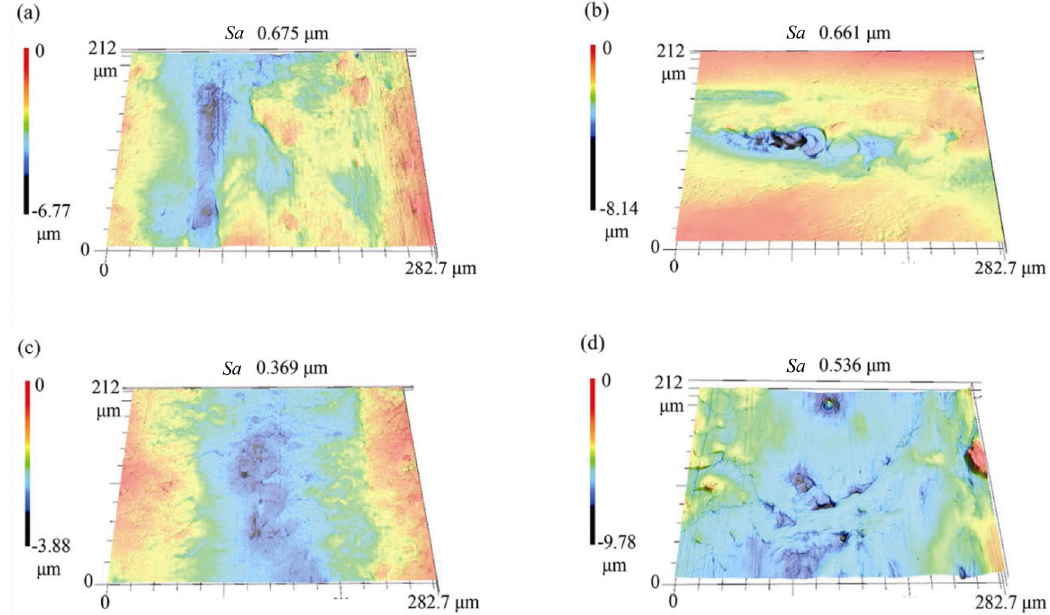
Fig. 10 3D wear surface topographies of polymer discs after the variable velocity tests under 10 N: (a) UHMWPE, (b) 50 DN, (c) 75 DN, and (d)